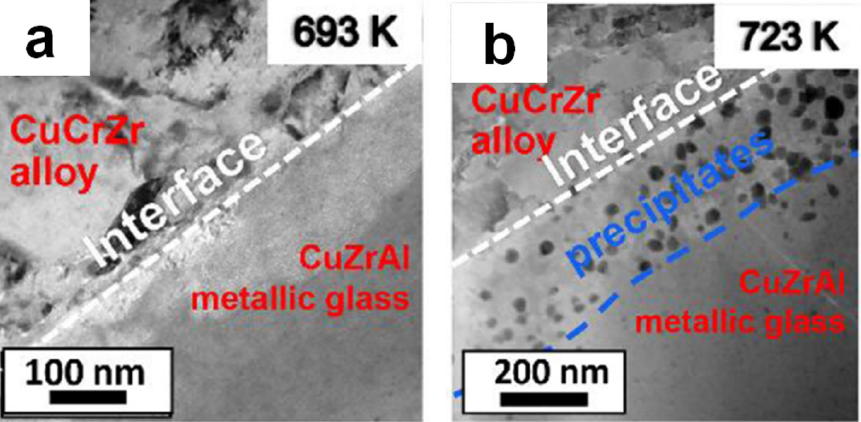
Figure 12. Transmission electron microscopy images of the interface in composites obtained via spark plasma sintering of CuCrZr alloy + 30 wt.% Cu 50 Zr 43 Al 7 metallic glass mixtures at 500 MPa at different temperatures: ( a ) 693 K and ( b ) 723 K. Reprinted from [88], Copyright (2022), with permission from Elsevier.